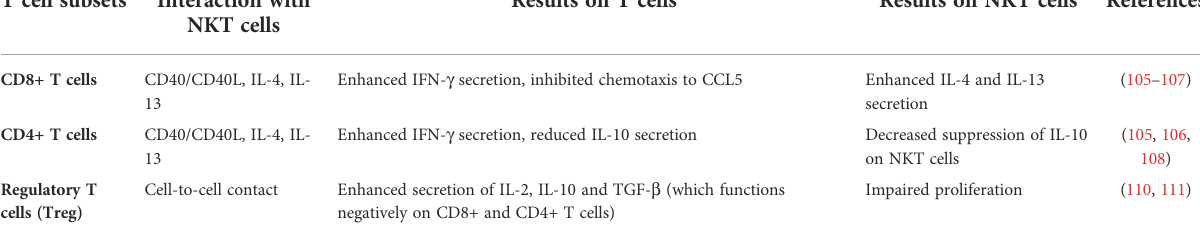
TABLE 3 Interactions between NKT cells and different subgroups of T cells. T cell